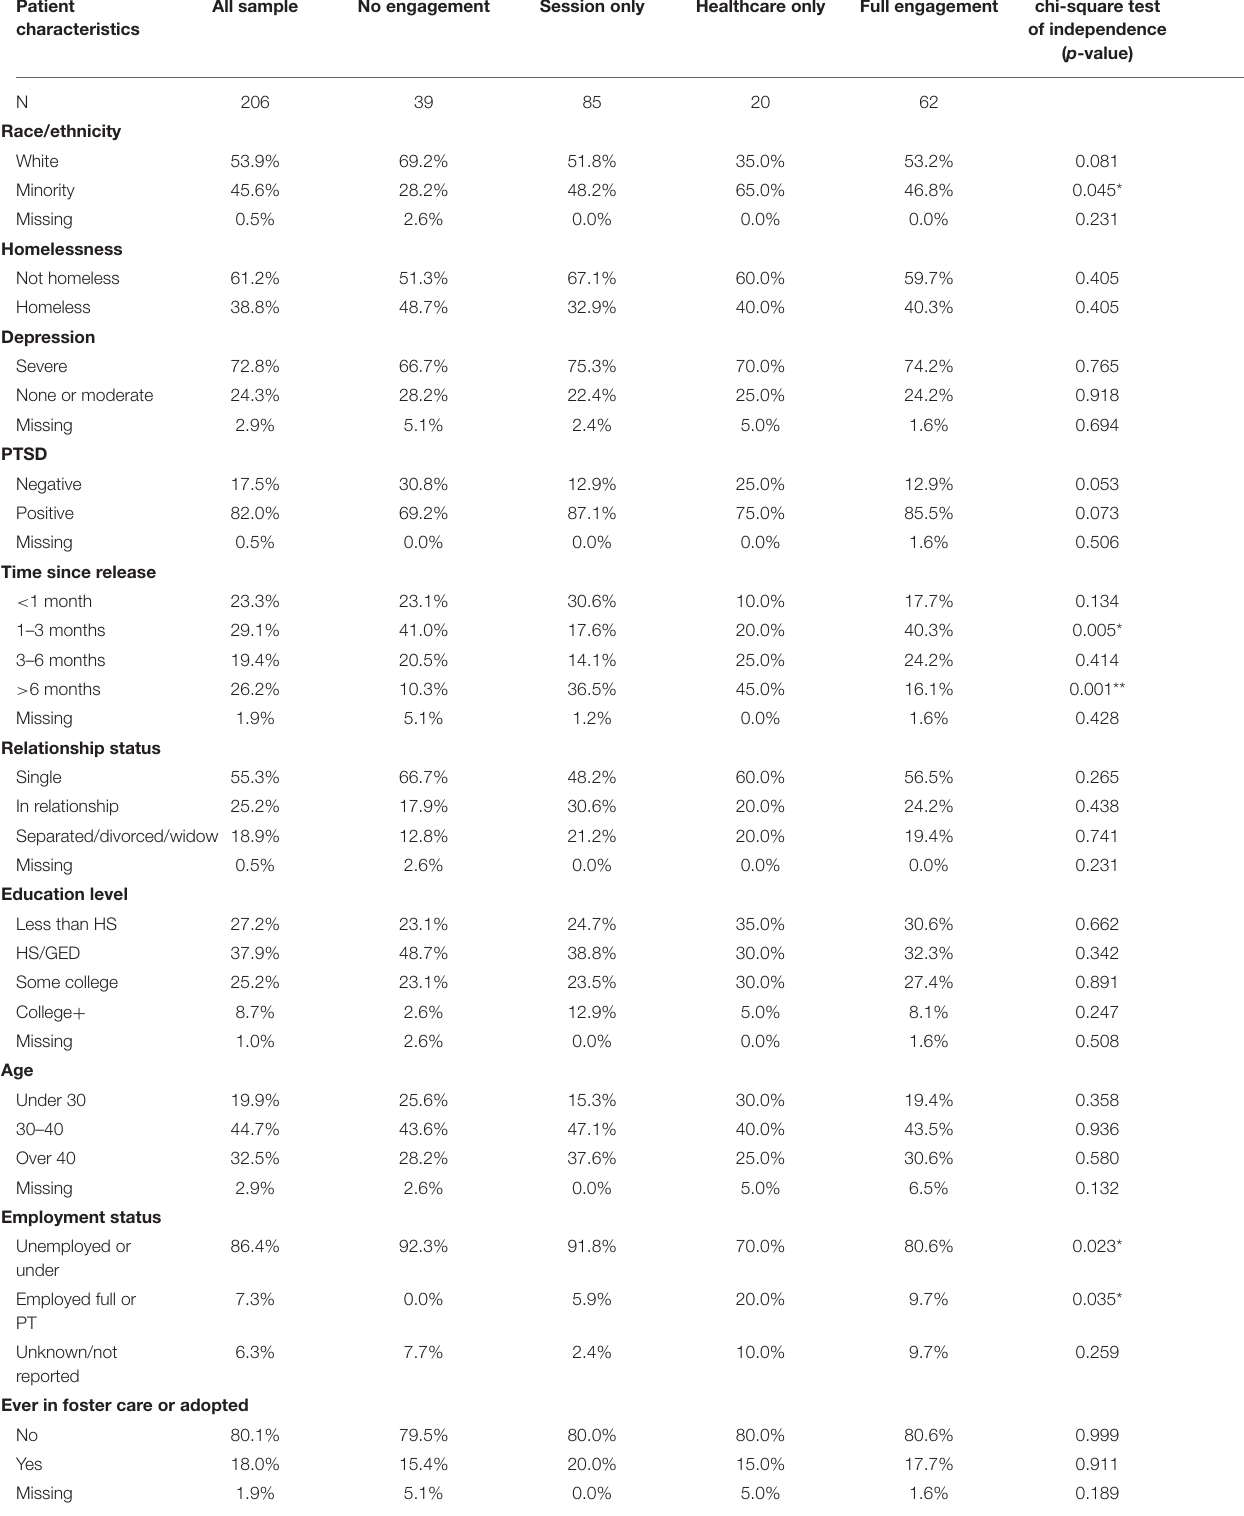
TABLE 1 | Descriptive statistics by engagement type. Patient